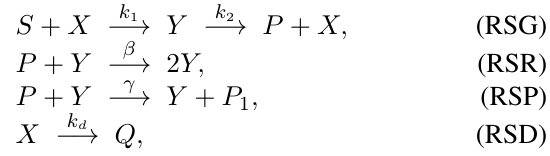
Fig. 7. Solution of model (3), 600